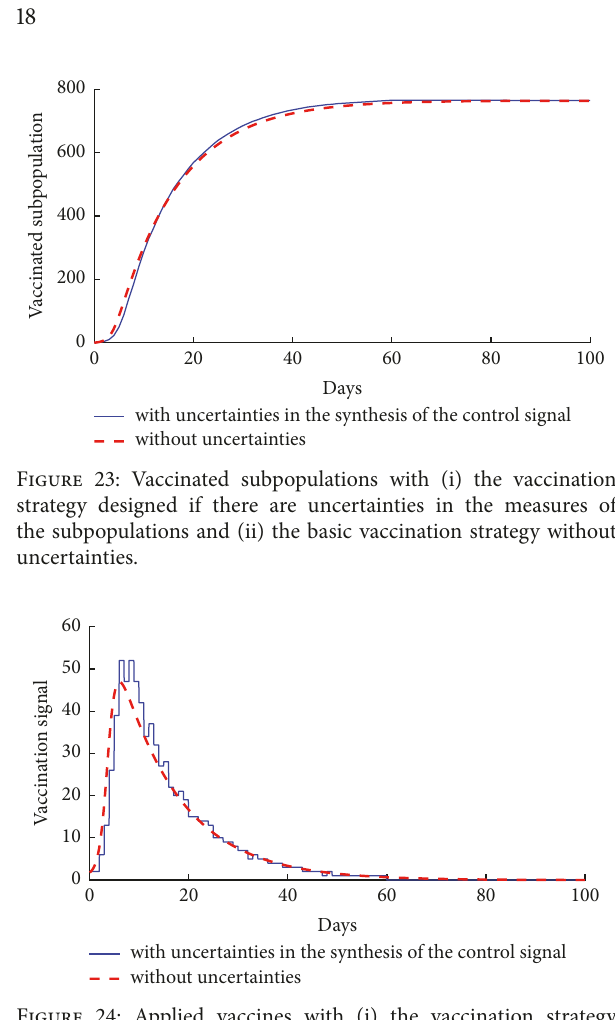
Figure 24: Applied vaccines with (i) the vaccination strategy designed if there are uncertainties in the measures of the subpopu- lations and (ii) the basic vaccination strategy without uncertainties.